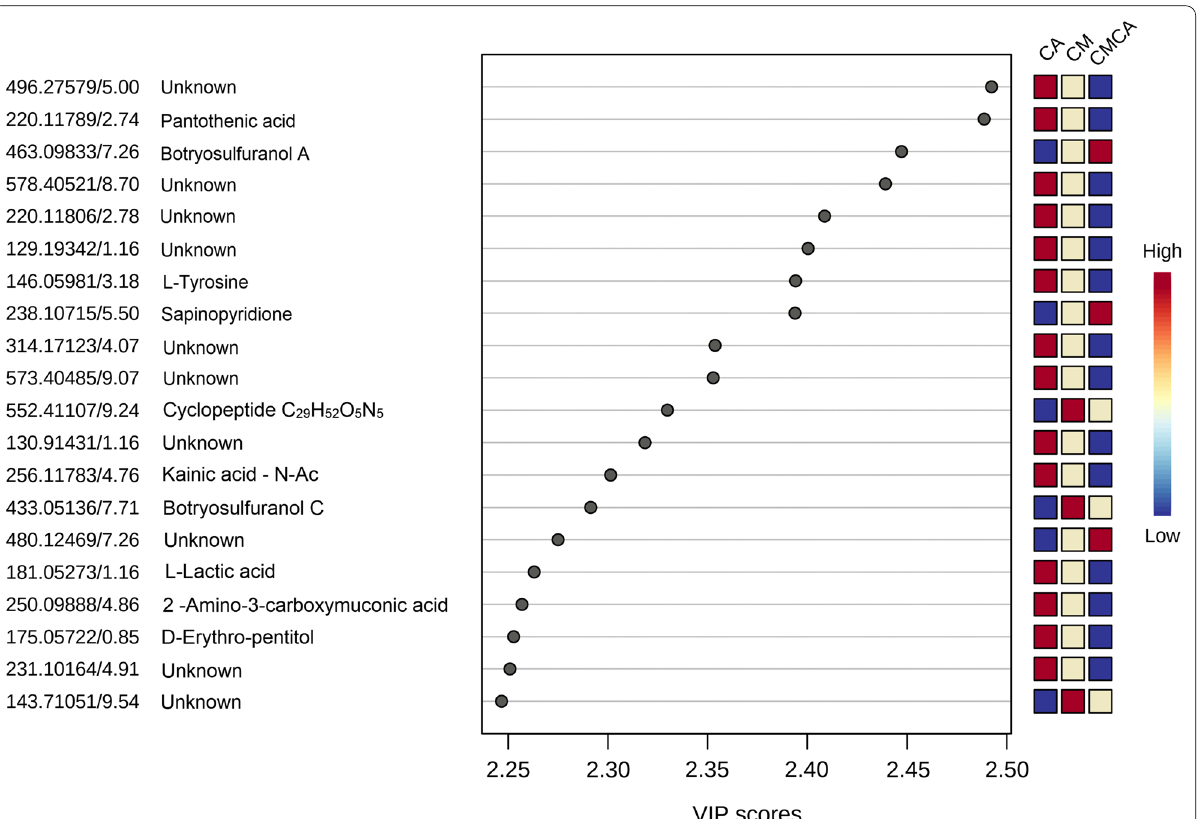
Fig. 4 The top 20 compounds according to the VIP score (p < 0.05) responsible for metabolite differentiation among cultures. The boxes on the right indicate the relative concentrations of each metabolite in each group. CM: Cophinforma mamane ; CA: Candida albicans , CMCA: co-culture of CM and